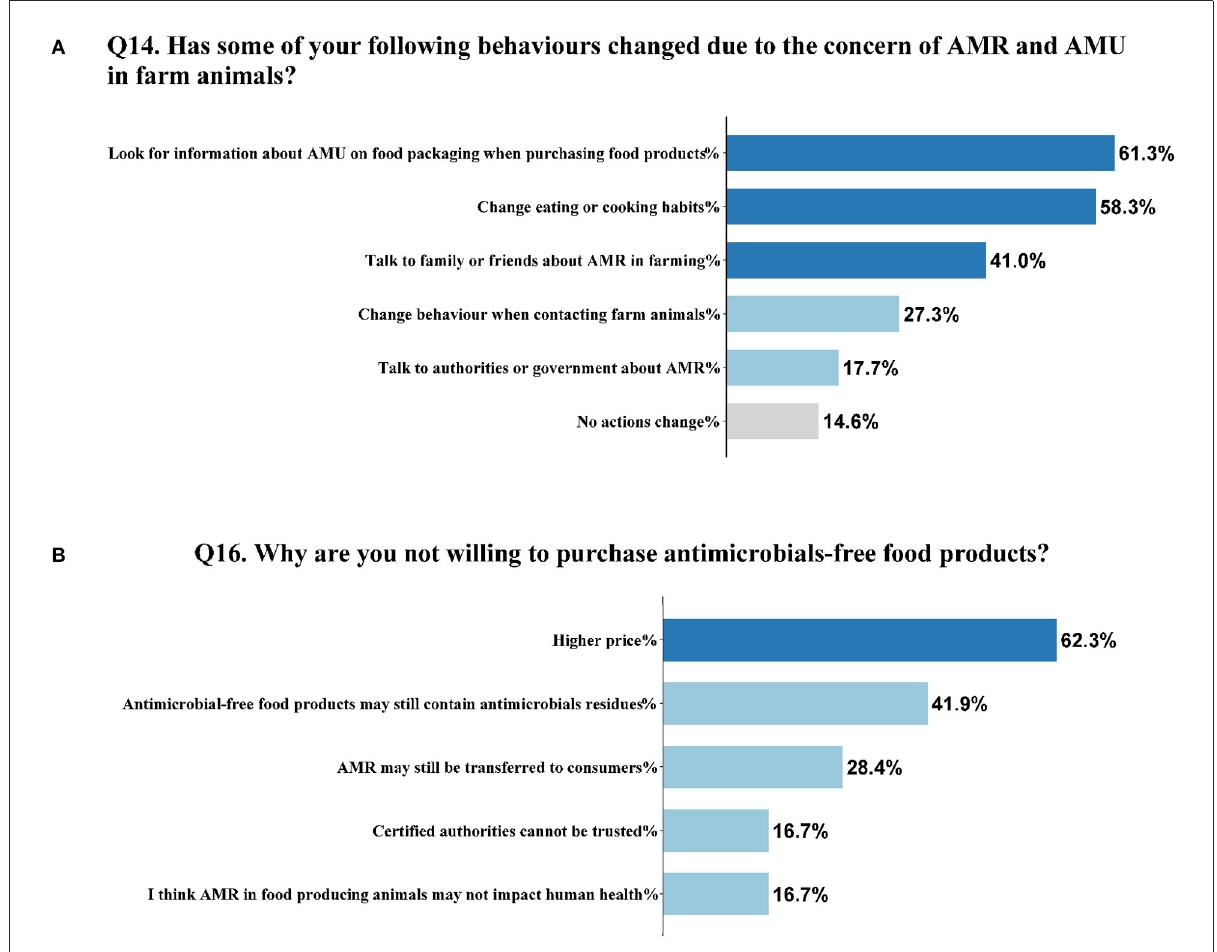
FIGURE3 Behavioral changes, and the reasons why consumers were not willing to pay extra for antimicrobials-free food products. (A) Behavioral changes due to the concern of AMR and AMU in farm animals (N = 1065). (B) The reasons why consumers were not willing to pay extra for antimicrobials-free products (N =